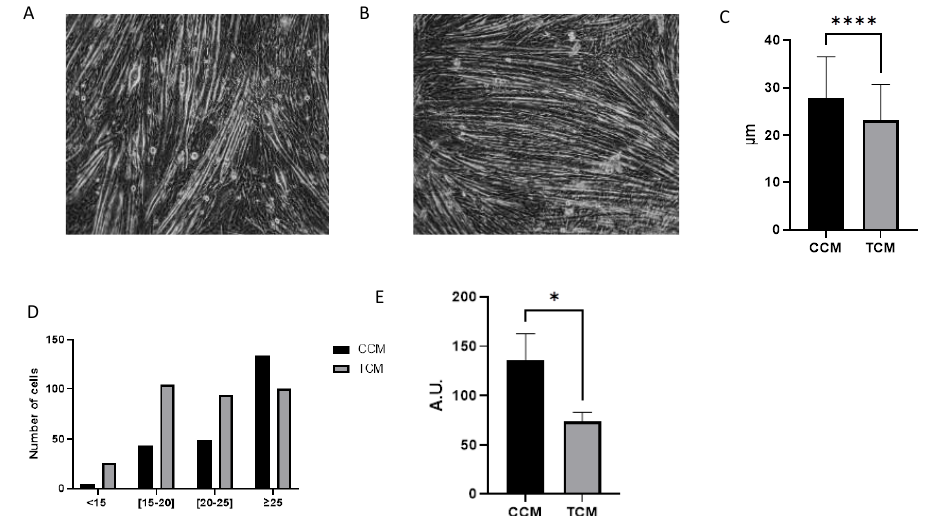
Figure 1. Effect of tumor cell-conditioned media or control-conditioned media on size and myosin content of C2C12-differentiated myotubes. ( A ) Picture of differentiated myotubes after incubation for 48 h with control-conditioned media (CCM). ( B ) Picture of differentiated myotubes after incubation for 48 h with tumor-conditioned media (TCM). ( C ) Average diameter analysis by microscopy of myotubes incubated with either CCM or TCM for 48 h (n = 231 for CCM and n = 324 for TCM), ****: p < 0.0001. ( D ) Number of myotubes classified according to their average diameter assessed by microscopy (in µ m) stratified by media (CCM or TCM); <15: average myotube diameter <15 µ m, [10–20]: average myotube diameter between 15 µ m and 20 µ m, [20–25]: average myotube diameter between 20 µ m and 25 µ m, ≥ 25: average myotube diameter ≥ 25 µ m. ( E ) Mean ± SD of myosin expression (heavy chain) assessed by Western blot analysis in C2C12 myotubes incubated with either TCM (n = 3) or CCM (n = 3).*: p < 0.05. AU: absorbance unit. The uncropped blots and molecular weight markers are shown in Supplementary Figure S1.